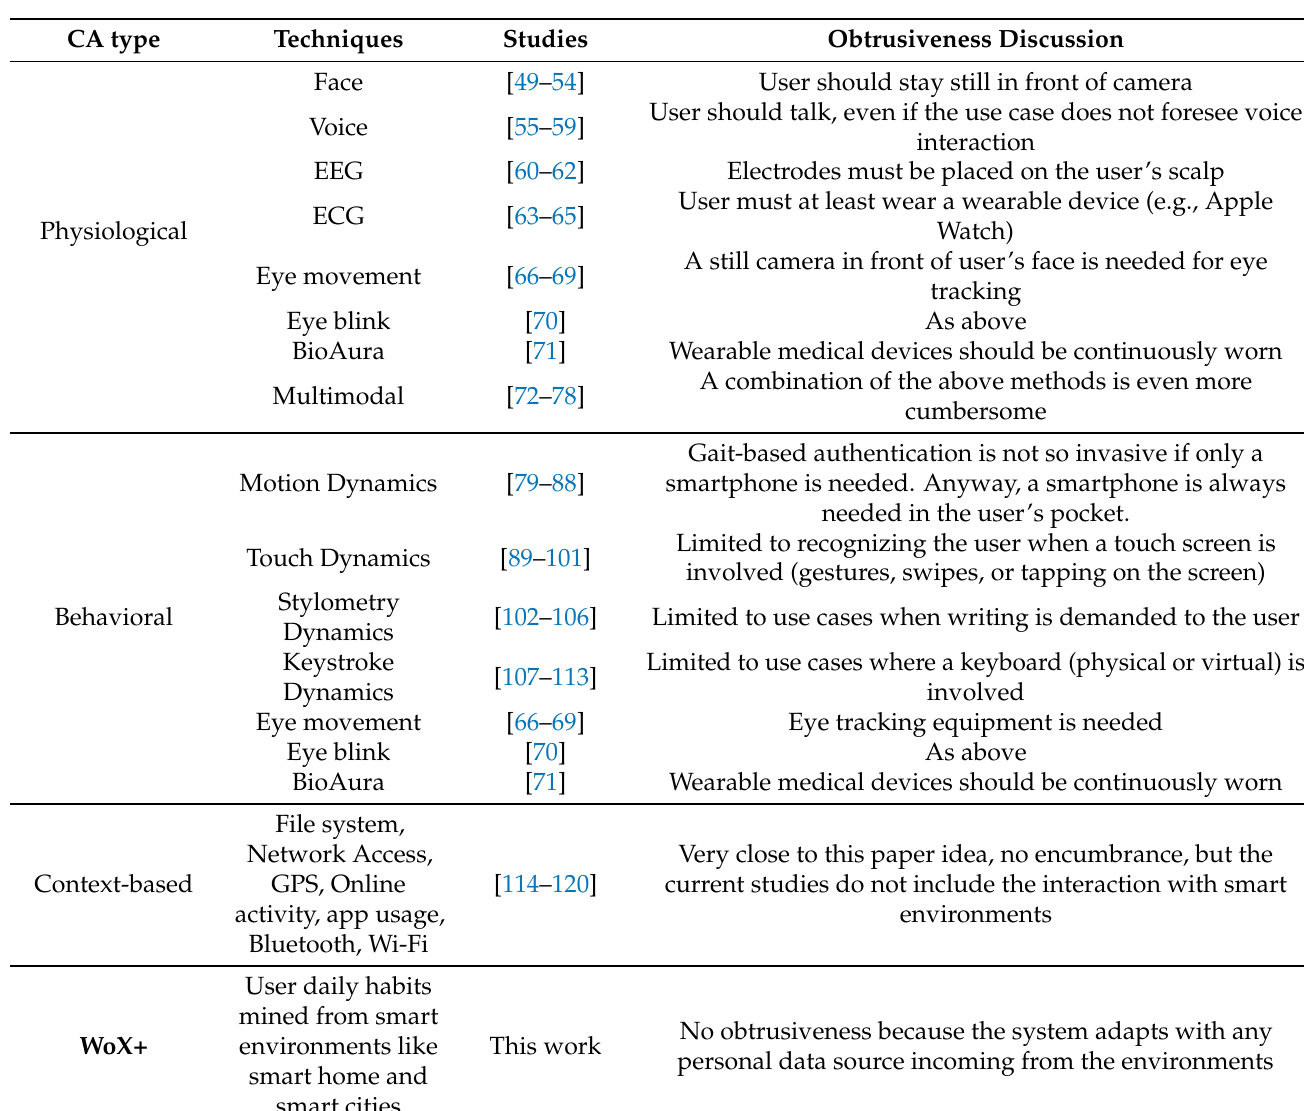
Table 4. Comparison and discussion of our approach against existing